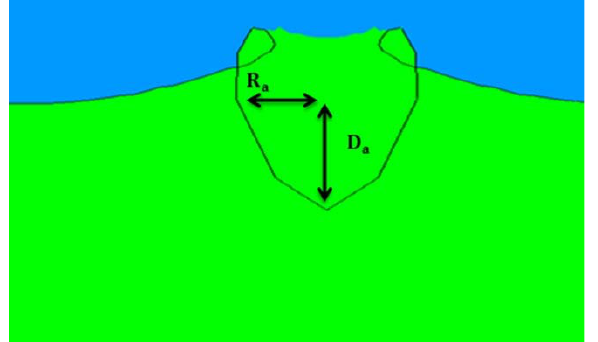
Figure 7: The apparent crater radius and depth, which is measured relative to the original